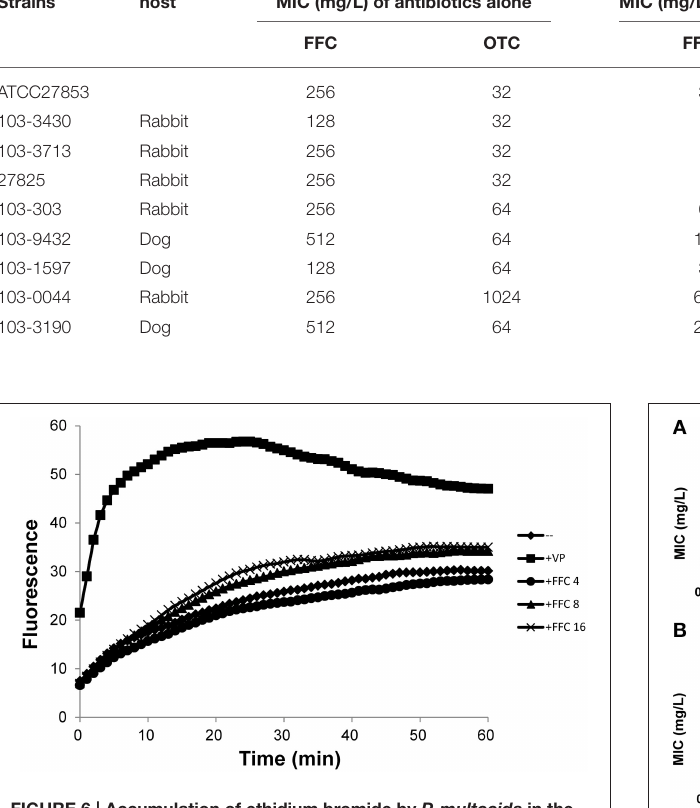
TABLE 2 | In vitro inhibitory activity of florfenicol (FFC) and oxytetracycline (OTC) alone and in combination against P . aeruginosa . Strains